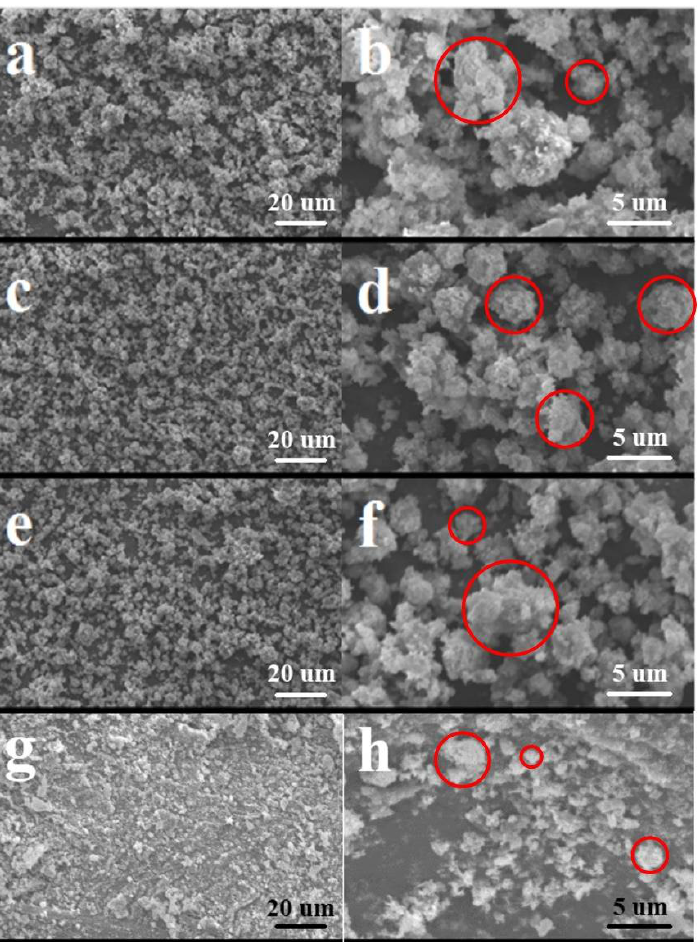
Figure 4. SEM results of the electrosprayed B (11%)/NC/CuO under ( a , b ) 16 kV, ( c , d ) 18 kV, ( e , f ) 20 kV, and ball-milled sample ( g , h ).